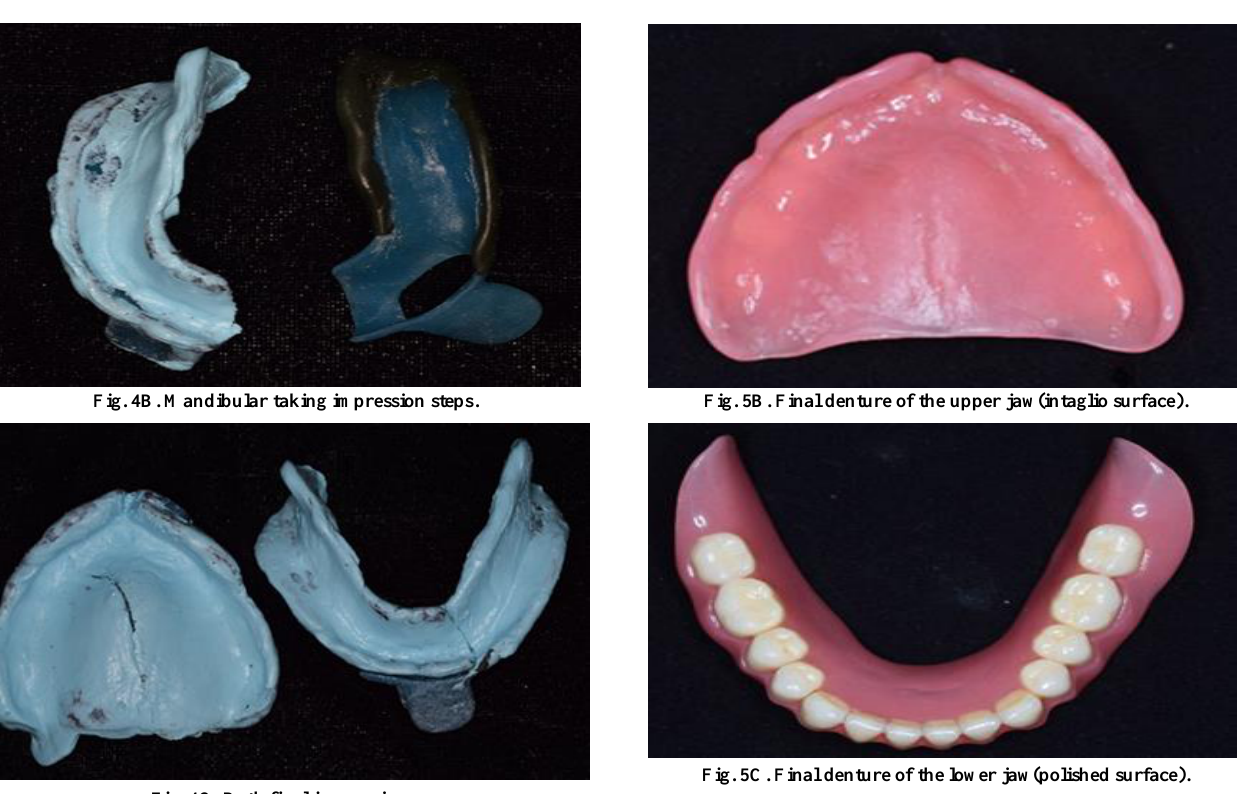
Fig. 4C. Both final impressions.